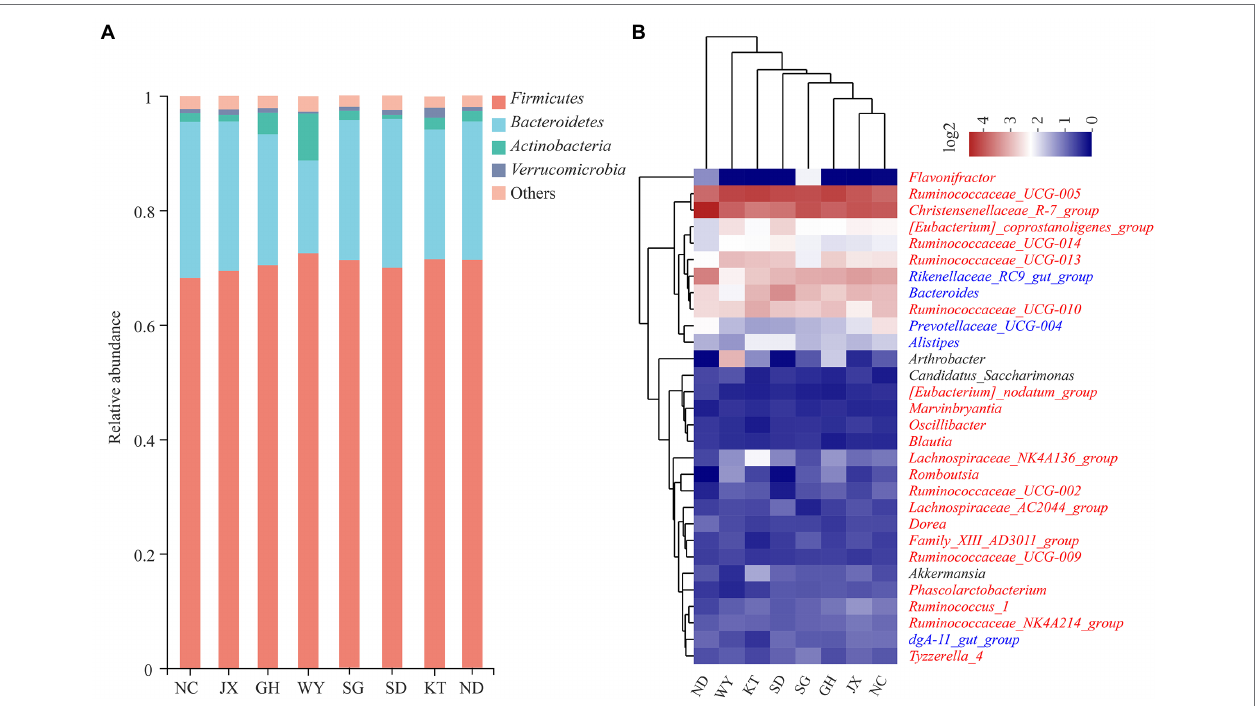
FIGURE 2 | The composition of the gut microbiota of Przewalski’s gazelle. (A) Relative abundance of the dominant bacteria among the groups of Przewalski’s gazelle at the phylum level. (B) Cluster heat maps of the top 30 bacterial genera in terms of